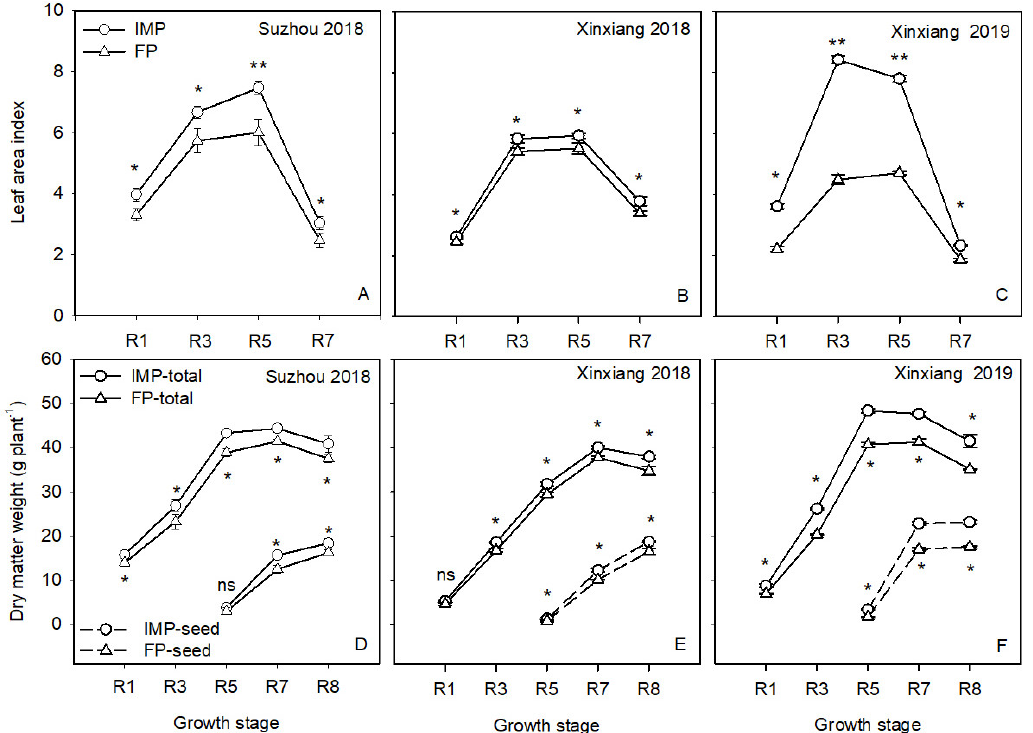
Figure 6. The effects of seeding management practices on leaf area index and dry matter weight for soybean. IMP, integrated management practice; FP, farmers’ practice. * and **, indicate significance different at the 0.05 and 0.01 probability levels, respectively. Ns indicates not significant different. The bottom and top bars of each dataset represent standard error. ( A ) represents the leaf area index of soybean at Suzhou site in 2018. ( B ) and ( C ) represent the leaf area index of soybean at Xinxiang site in 2018 and 2019, respectively. ( D ) represents the dry matter weight of soybean at Suzhou site in 2018. ( D ) and ( F ) represent the dry matter weight of soybean at Xinxiang site in 2018 and 2019, respectively.